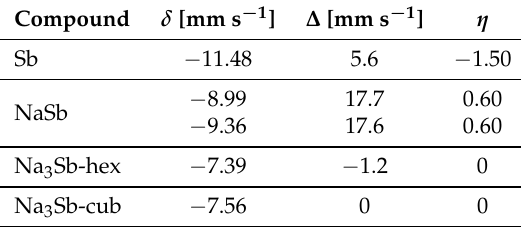
Table 2. Calculated 121 Sb Mössbauer hyperfine parameters at 0K for Sb and the Na-Sb